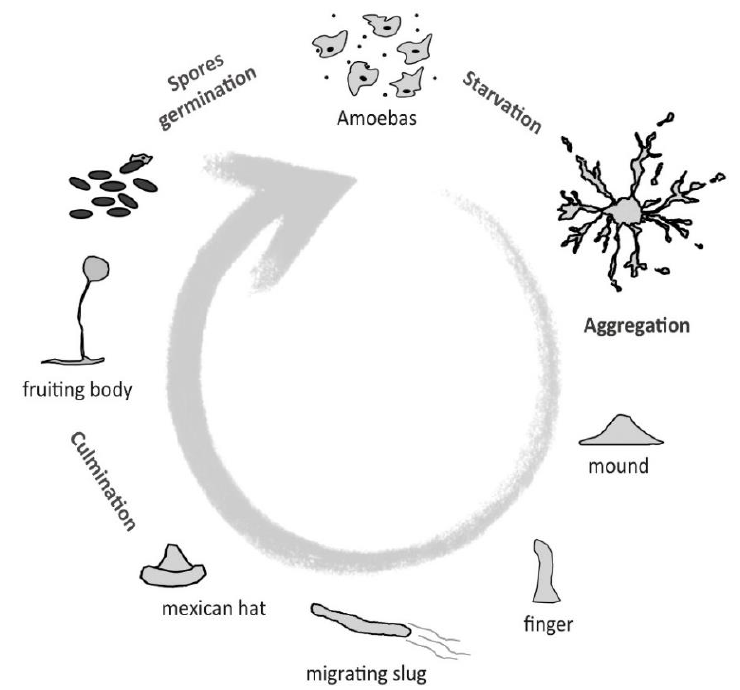
Figure 1. Diagram of the Dictyostelium life cycle. Individual amoebas feed on yeast and bacteria, and multiply via fission. When nutrients are scarce, cells aggregate and undergo a developmental program, comprised of distinct stages that culminate in the formation of a fruiting body, which is composed of a stalk, and a sorogen filled with spores. Under suitable environmental conditions, the spores germinate.